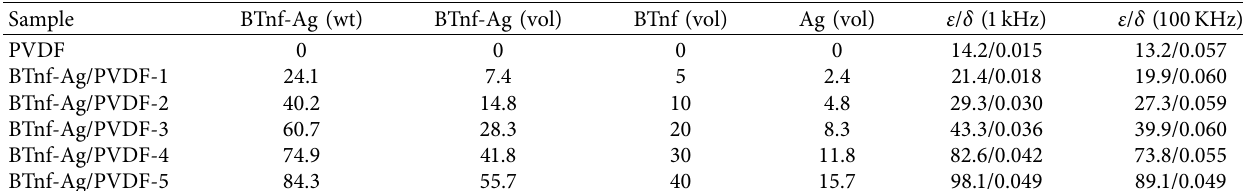
Table 2: The content of each component in the BTnf-Ag/PVDF hybrid particles.